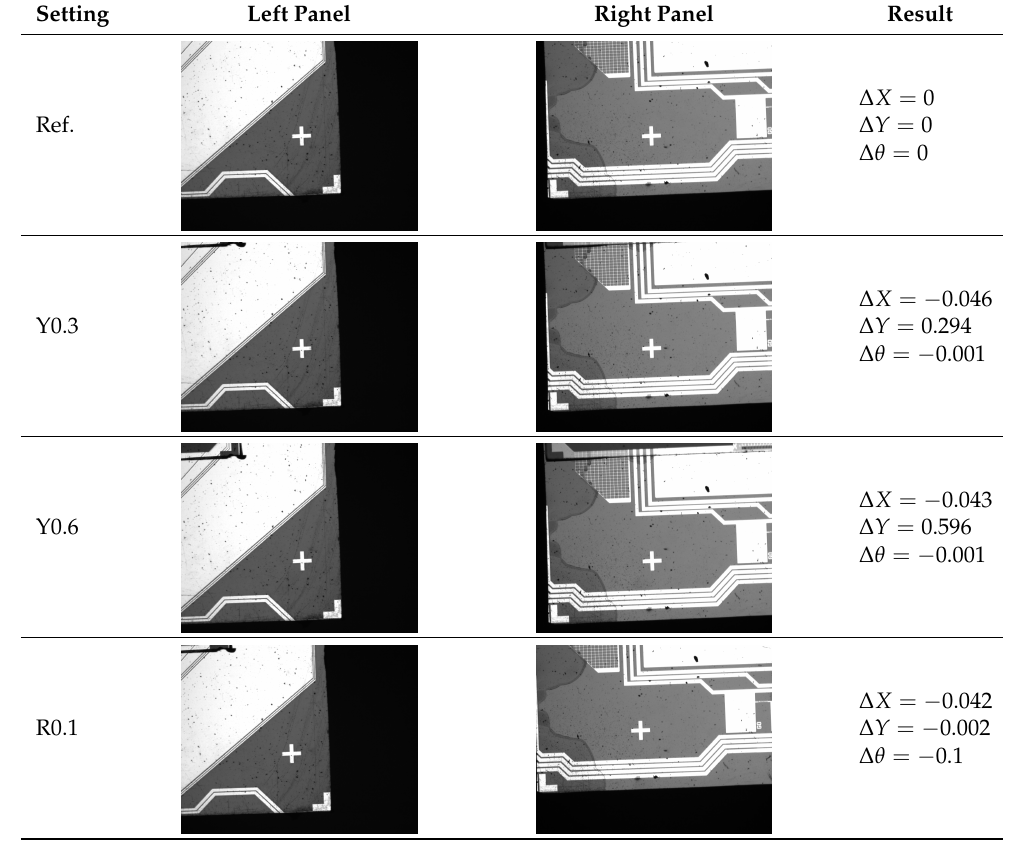
Table 4. The result of misalignment correction in different settings (unit: ∆ X ( mm ) , ∆ Y ( mm ) , ∆ θ ( ◦ ) ).